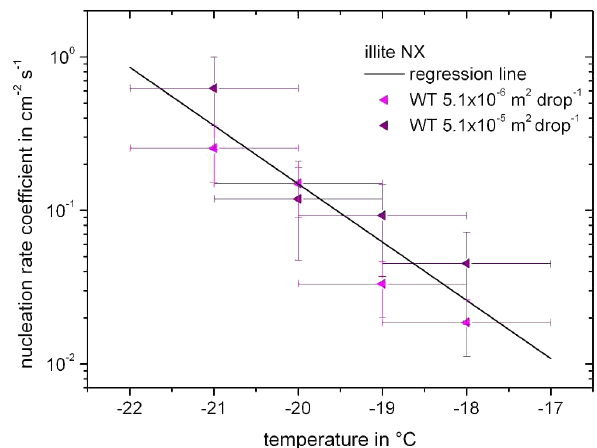
Figure 5. Nucleation rate coefficients as function of temperature for illite NX for two particle surface areas per drop investigated in the wind